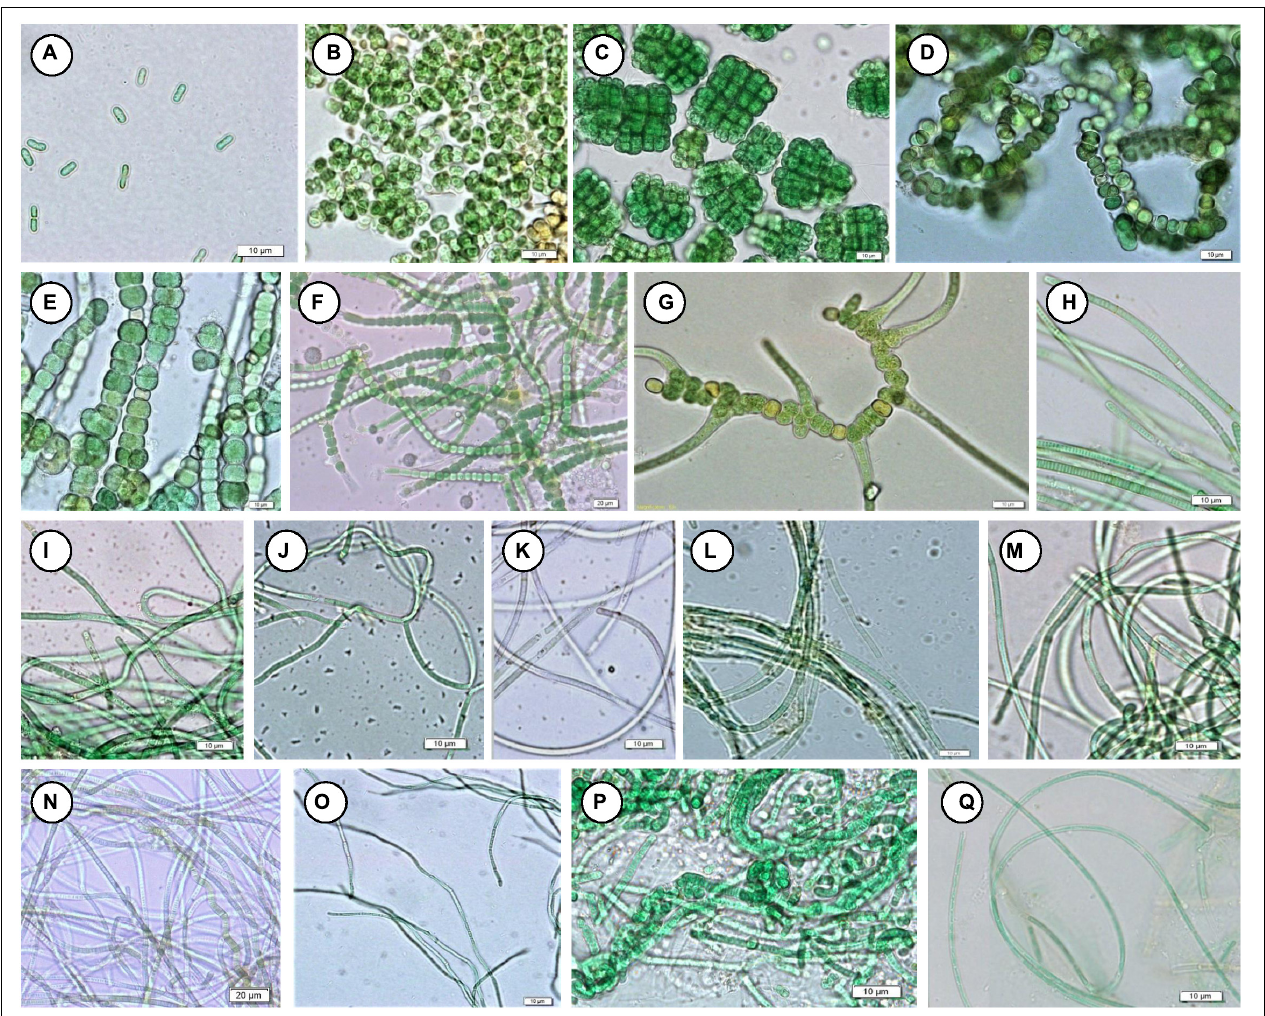
FIGURE 6 | Mat-forming cyanobacteria identified in this study. (A) Synechococcus cf. nidulans , (B) Gloeocapsa gelatinosa , (C) Chlorogloeopsis fritschii , (D) Anabaena sp. NK1-14, (E) Fischerella sp. NK 1-16, (F) Fischerella sp. NK 1-20, (G) Fischerella thermalis , (H) Planktothrix cryptovaginata , (I) Leptolyngbya copelandii , (J) L. dangeardii , (K) L. faveolarum , (L) Leptolyngbya sp. NK 1-10, (M) Leptolyngbya sp. NK 1-23, (N) Leptolyngbya sp. NK 1-12, (O) Thermoleptolyngbya oregonensis , (P) Leptolyngbya thermobia , (Q) L. valderiana